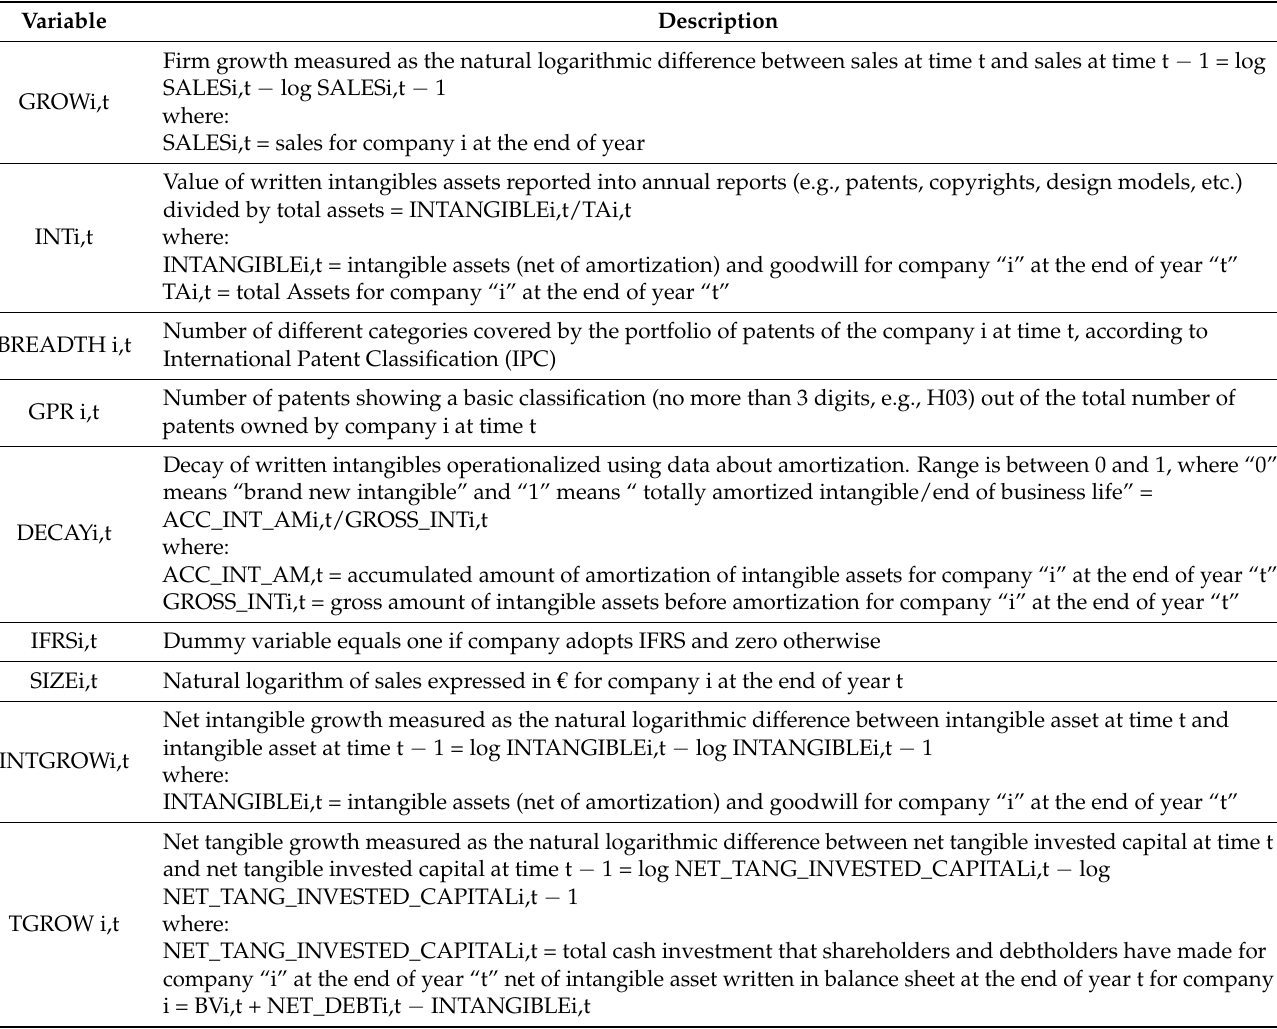
Table 4. Description of